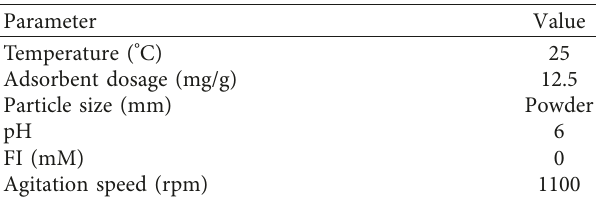
Table 4: Optimum adsorption